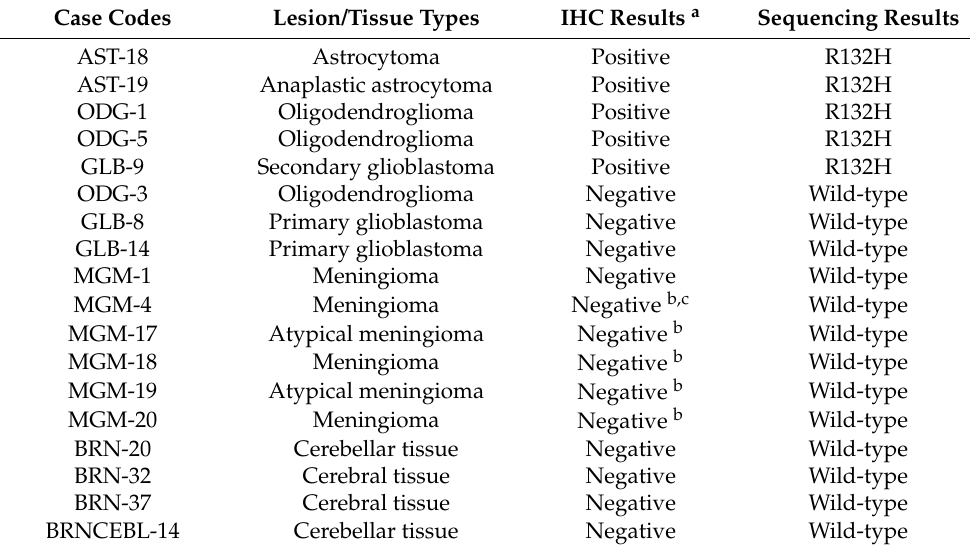
Table 6. IDH1 R132H IHC and sequencing test results in 18 informative